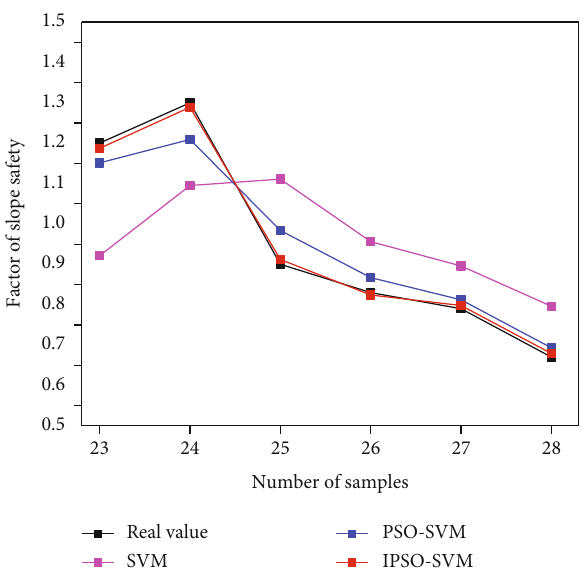
Figure 5: Comparison of di ff erent prediction models and true